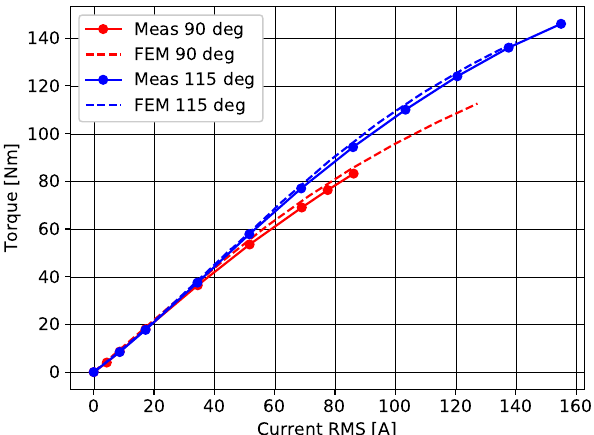
Figure 14. Average torque output at 150 rpm rotor speed, 90 and 115 deg current angle. Measurement and simulation comparison.